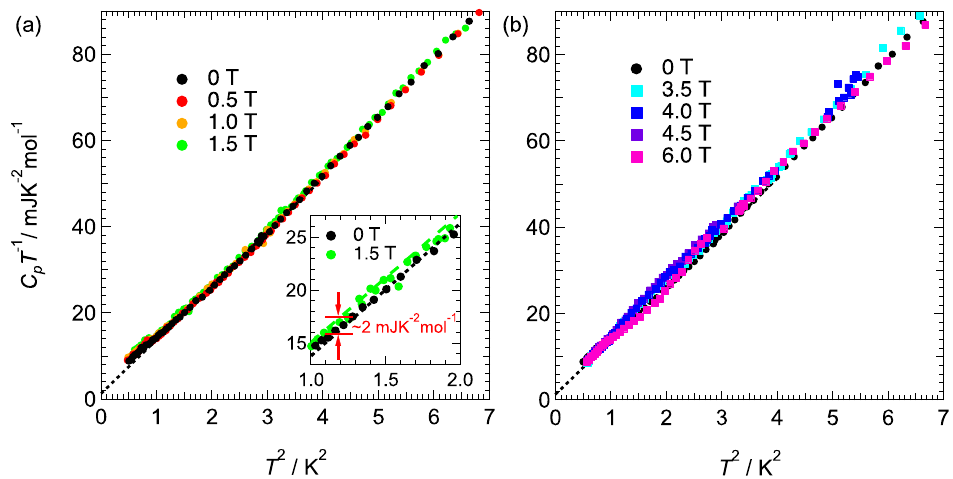
Figure 4. C p T −1 vs. T 2 plot of the partially deuterated d[3,3] compound obtained under magnetic fields applied perpendicular to the donor layer. The lower-field data of 0 T, 0.5 T, 1.0 T, and 1.5 T are shown in ( a ), and those at higher fields of 3.5 T, 4.0 T, 4.5 T, and 6.0 T are shown in ( b ) together with the data at the magnetic field of 0 T. The broken line represents the fitting result of 0 T using C p T −1 = γ + βT 2 . The inset in ( a ) is an enlarged plot of the datasets at magnetic fields of 0 T and 1.5 T around 1.0 K to make the field dependence clearer.